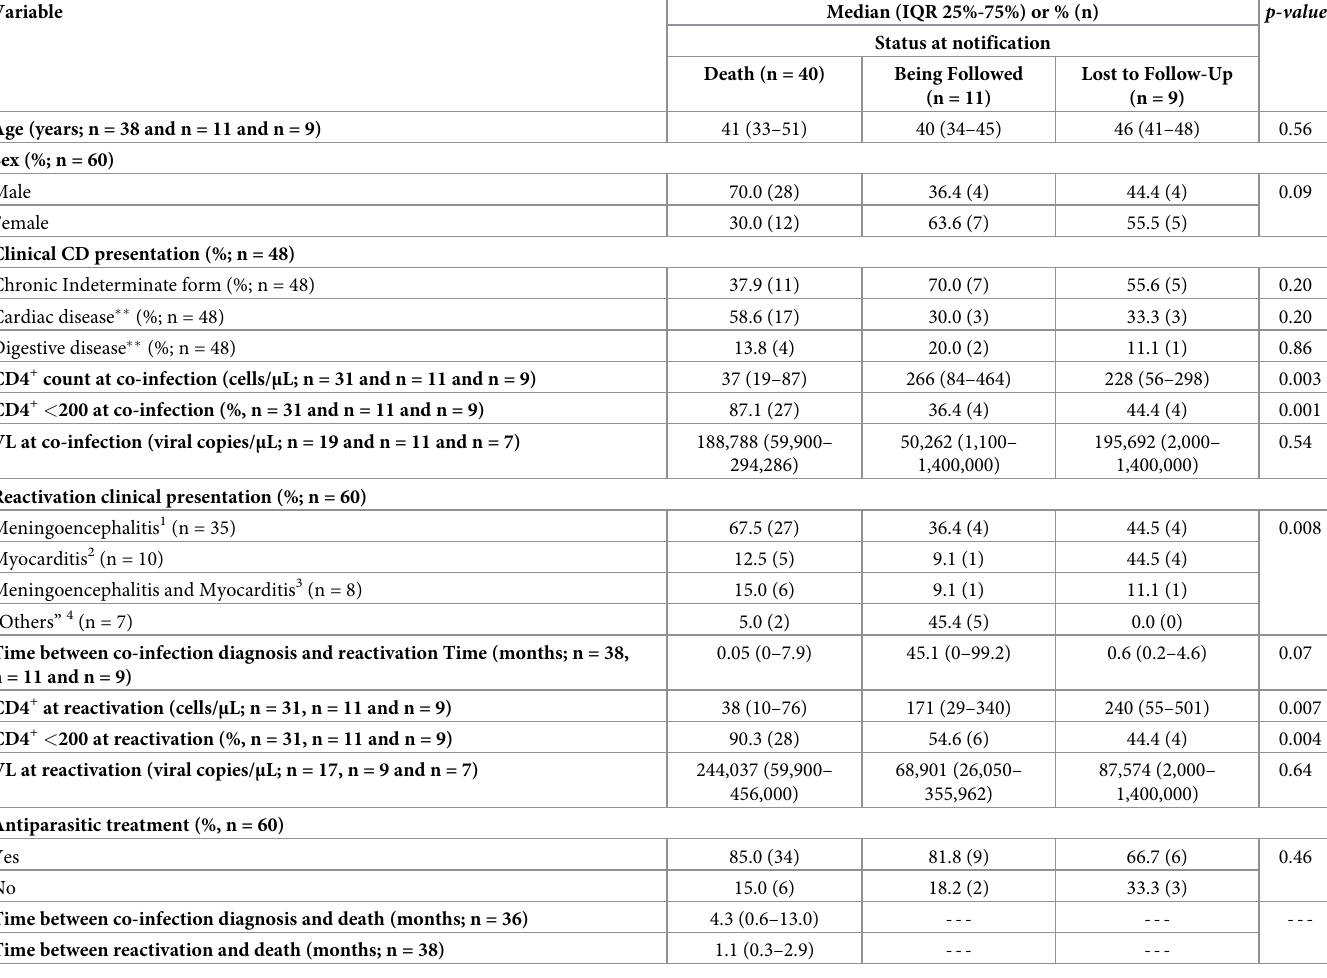
Table 3. Characteristics of patients that presented Chagas disease reactivation according to status at notification (n = 60).